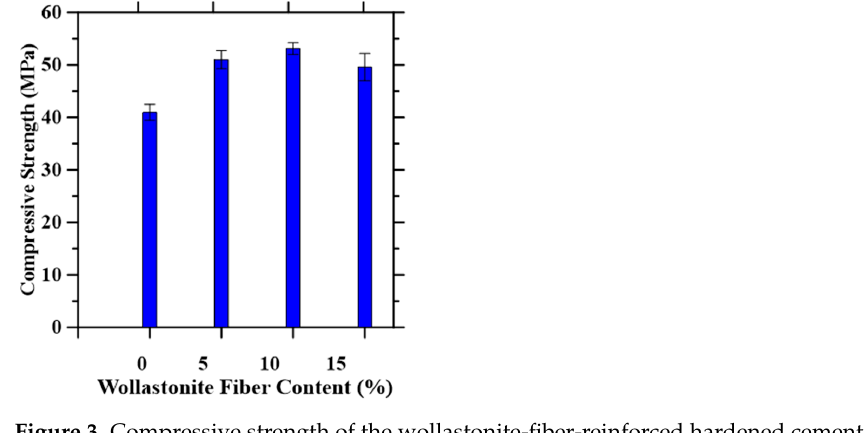
Figure 3. Compressive strength of the wollastonite-fiber-reinforced hardened cement pastes under quasi-static loading condition.